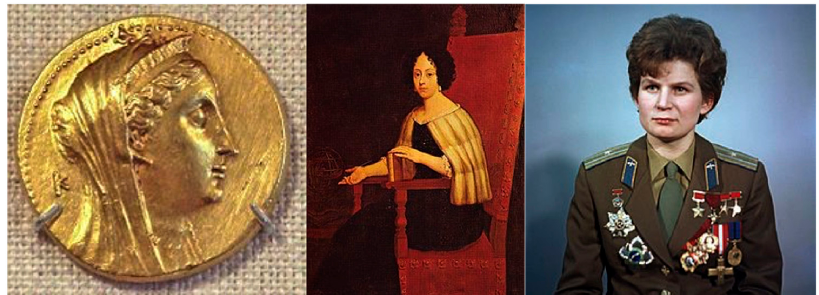
Figure 3. Task images [task solution: the main element that connects the three women is the fact that they were the first to achieve something. The woman in the coin is Arsinoe II, the first mortal female depicted on a coin (Egypt, 3rd century BC). The woman in the middle is Elena Cornaro Piscopia, the first woman to receive a University degree (University of Padua, 1678). The woman on the right is Valentina Tereshkova, the first woman in space (USSR,